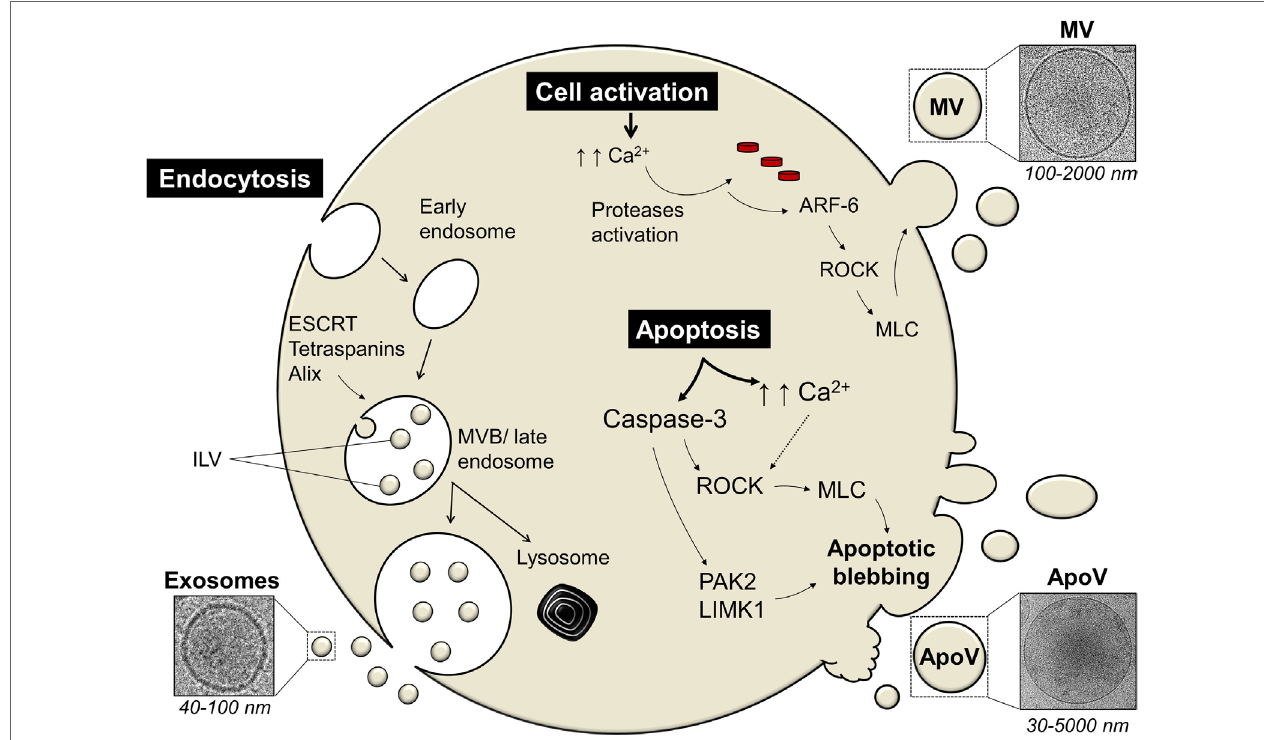
FiGURe 1 | The mechanism of extracellular vesicles (EVs) release differs among different types of EV. Exosomes are secreted via the endosomal pathway, starting with the inward invagination of the cell membrane forming an early endosome. In later stages, further invagination of the endosome leads to the formation of intraluminal vesicles (ILV) and this late endosome is now referred to as a multivesicular body [MVB; Ref. (38, 76)]. The MVB can either be targeted for cellular destruction/recycling by lysosomes or it may fuse with the cell membrane thus releasing ILV as exosomes. Proteins involved in exosomal machinery include the endosomal sorting complexes required for transport (ESCRT), tetraspanins (such as CD9), ALG-2-interacting protein X (Alix), and tumor susceptibility gene 101 [TSG101; Ref. (74)]. Microvesicles (MV) and apoptotic vesicles (ApoV) are secreted via the direct outward budding of the cell membrane. Cellular activation or apoptosis results in an increased influx of calcium ions (Ca 2 + ) which triggers proteases, such as calpain or gelsolin (80). These activated proteases lead to cytoskeletal disruption. ADP-ribosylation factor-6 (ARF-6) initiates a signaling cascade eventually activating the Rho-associated protein kinase (ROCK) signaling pathway which in turn activates myosin light-chain (MLC) kinases that activates and phosphorylates MLC that would initiate blebbing eventually leading to ApoV/MV release (81, 82). Apoptosis initiation also activates apoptotic enzymes known as caspases. Caspase-3 can cleave ROCK transforming it into a constitutive truncated form which then enhances the phosphorylation and activation of MLC that leads to ApoV shedding (83). Caspase-3-mediated blebbing can also act on other blebbing-mediated proteins, such as LIM domain kinase 1 (LIMK1) or p21-activated kinase (PAK2); reviewed in Ref.